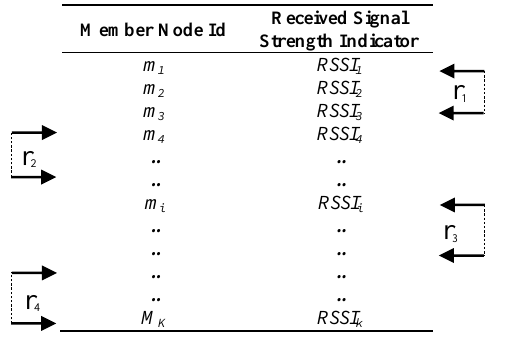
Figure 7. Segmentation architecture of member nodes inside a sector. Table 2. Member table of a SH node.